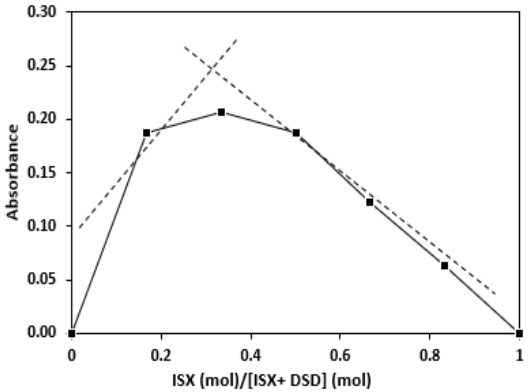
Figure. 2: Job’s method of the reaction between ISX and